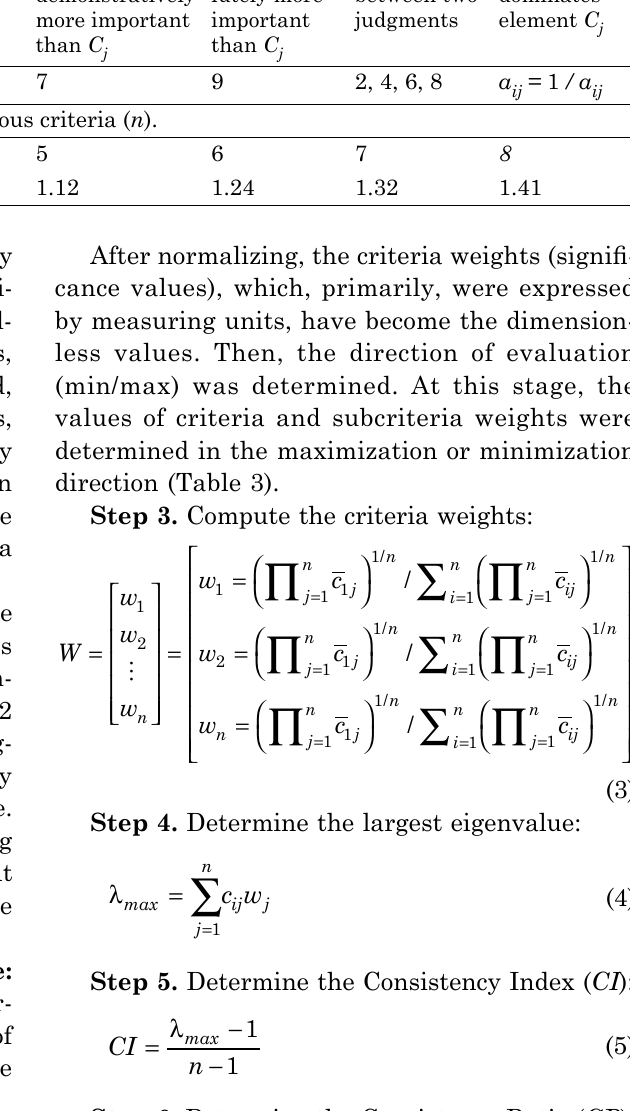
Table 1. The initial data used for pairwise comparison Saaty’s classical nine-point scale of relative importance Diagonal elements i =